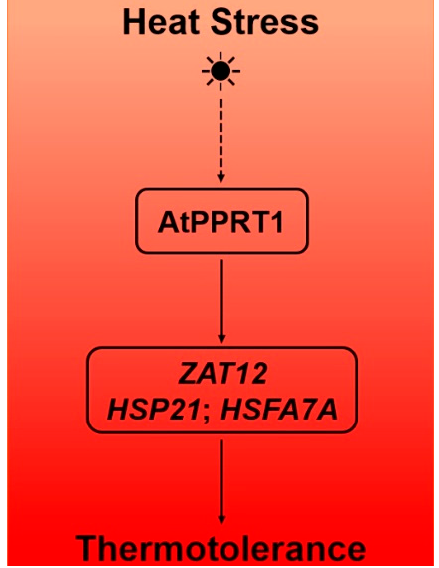
Figure 6. Model illustrating how AtPPRT1 responds to heat stress in Arabidopsis .